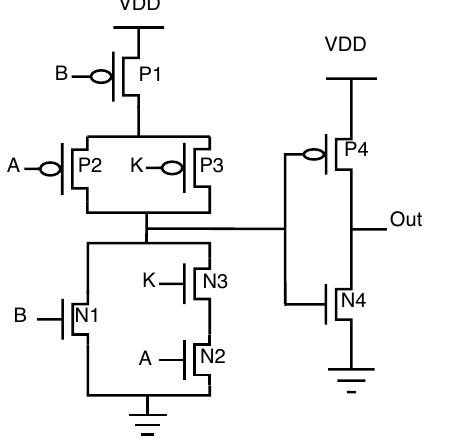
Figure 17. Secure OR.